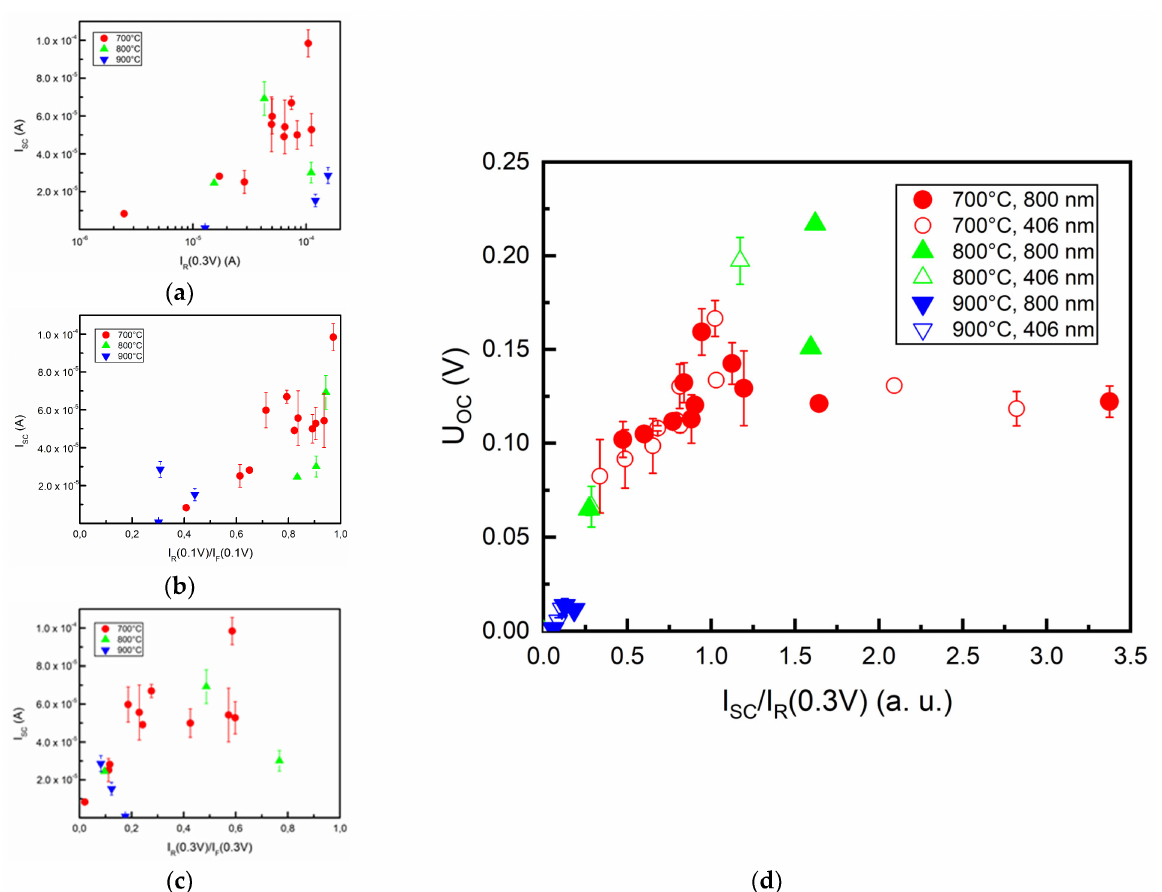
Figure 7. Diode I − V and photovoltaic parameter (at 800 nm illumination) relation: ( a ) I SC vs. I R (0.3 V) plot; I SC correlation with diode’s I-V curve shape estimated using reverse and forward current ratio measured at 0.1 V ( b ) and 0.3 V ( c ); U OC vs. I SC /I R (0.3 V) plot ( d ) (solid and hollow markers indicate device illumination at 800 and 406 nm,